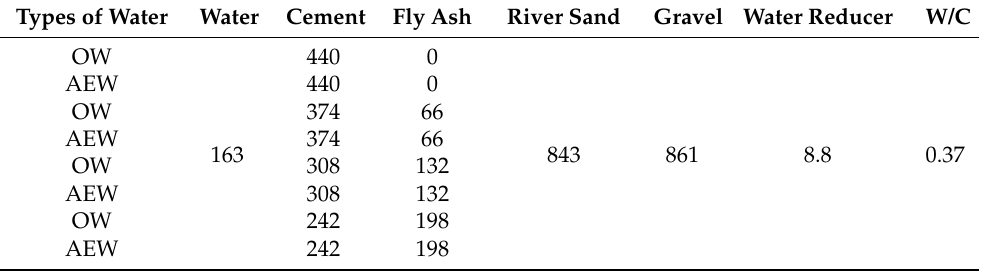
Table 6. Mix proportion of the FAC (kg/m 3 ).